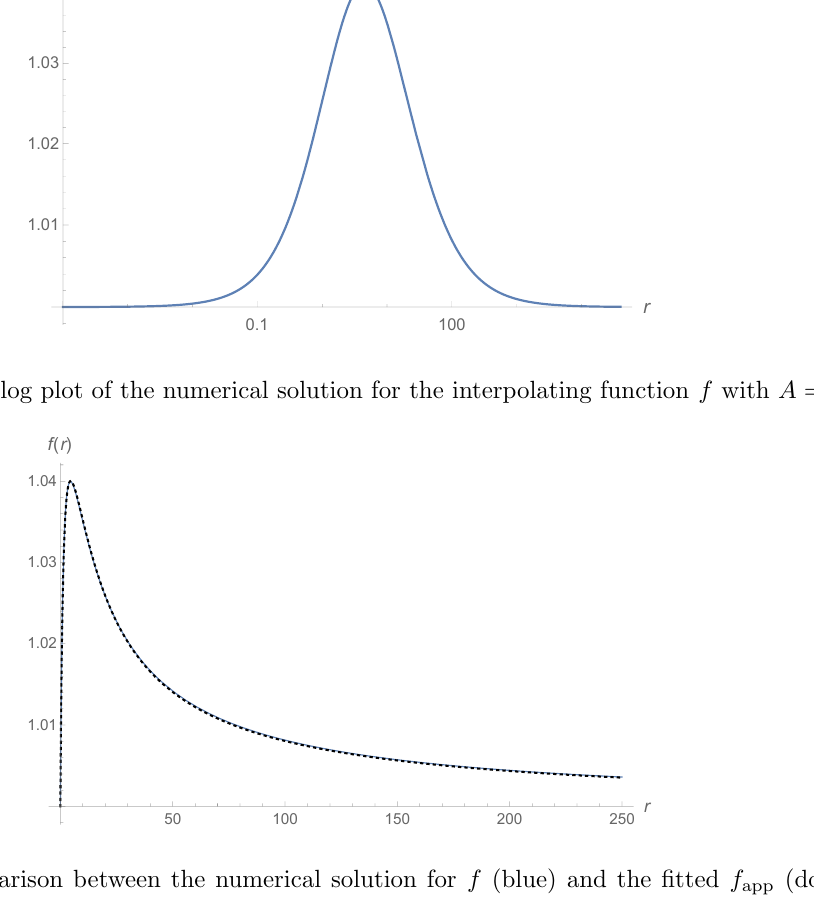
Figure 7 . Comparison between the numerical solution for f (blue) and the (cid:12)tted f app (dotted) for A =